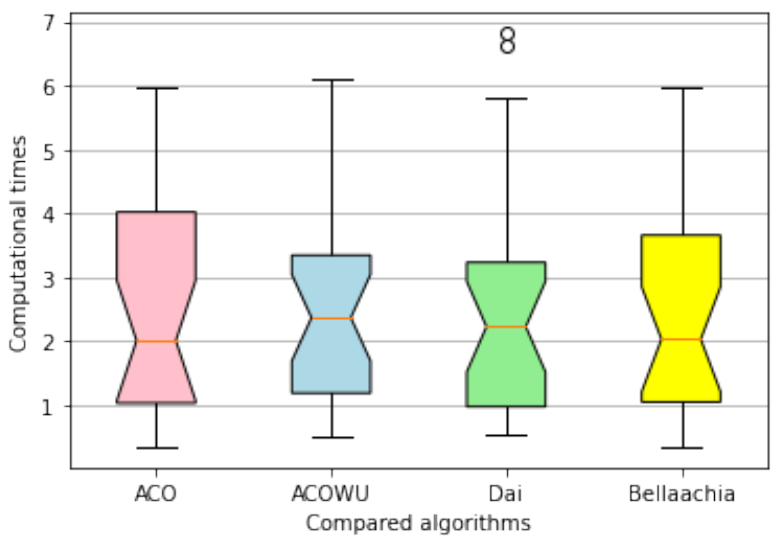
Figure 3. Comparison of solutions explored on generic TSP